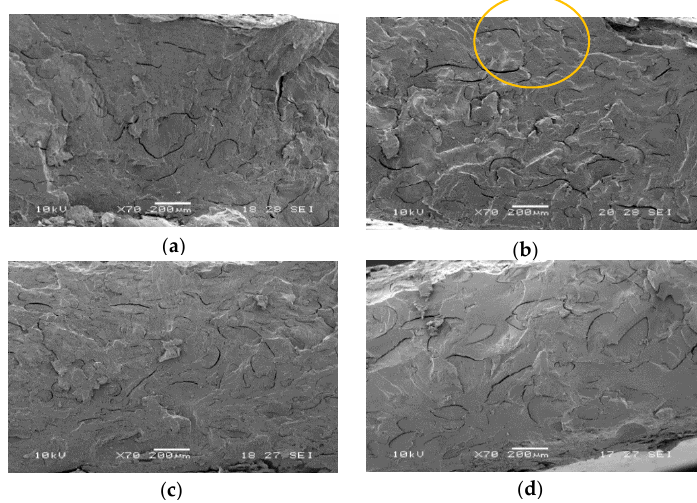
Figure 1. SEM micrographs related to: ( a ) PBS/PWP 50/50; ( b ) PBS/PWP 60/40; ( c ) PBS/PWP 65/35; ( d ) PBS/PWP 70/30. One big domain is circled in ( b ) as example.